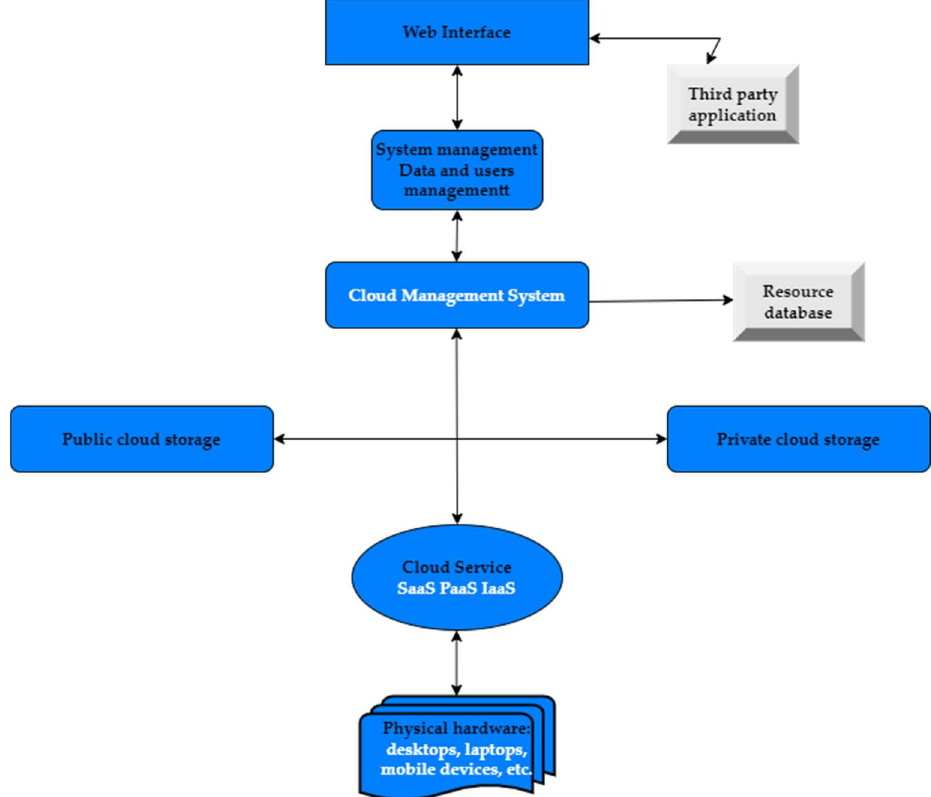
Figure 1. A simplified cloud computing-based E-Learning system architecture. Source: The authors.